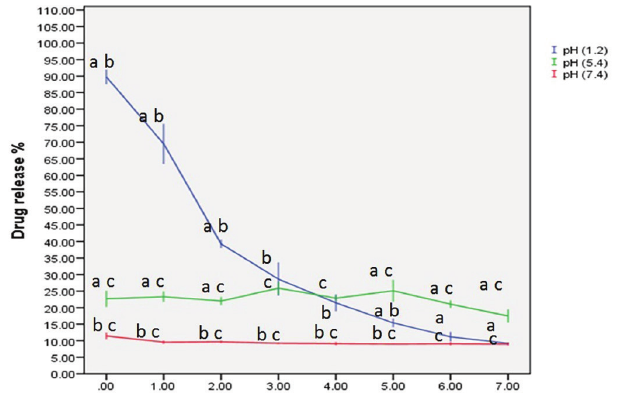
FIGURE 7 - Cumulative drug release at different pH